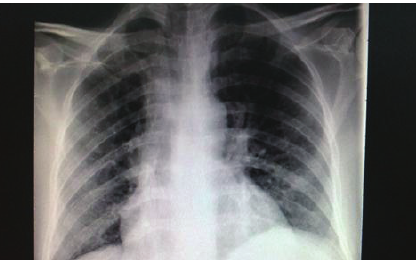
Figure 1: Chest X-ray.